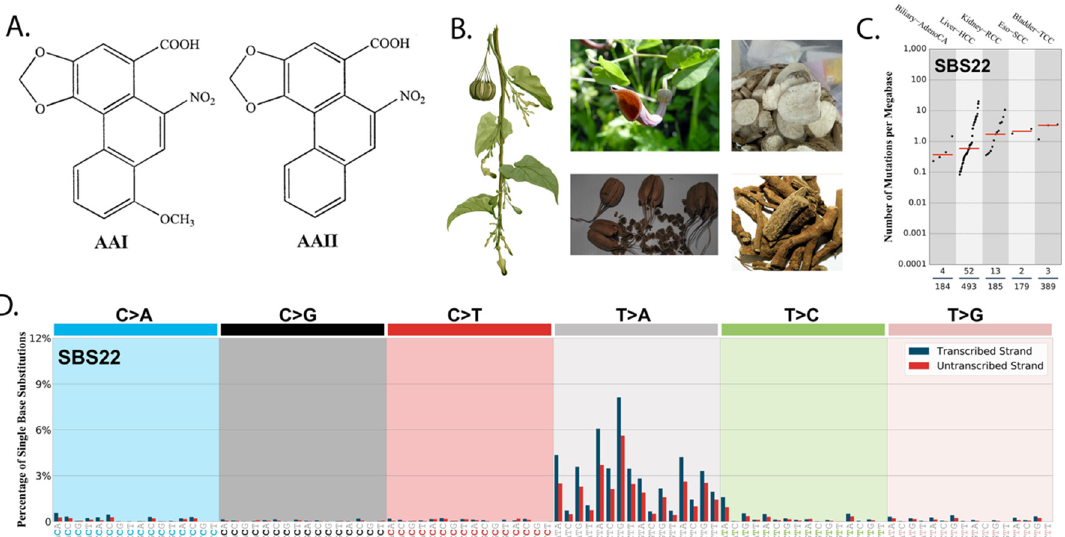
Figure 1. Prevalence of AA mutations in cancers. ( A ) Chemical structure of AA. ( B ) Aristolochia acuminata and images of flower, dried fruits, and rhizomes from Aristolochia species containing AA. ( C ) Tumor mutational burden of cancers with presence of AA signature. ( D ) The 384 mutational type classification with an AA signature. (Downloaded from: https://cancer.sanger.ac.uk/cosmic/signatures/SBS/SBS22.tt, Date accessed: 25 April 2021).